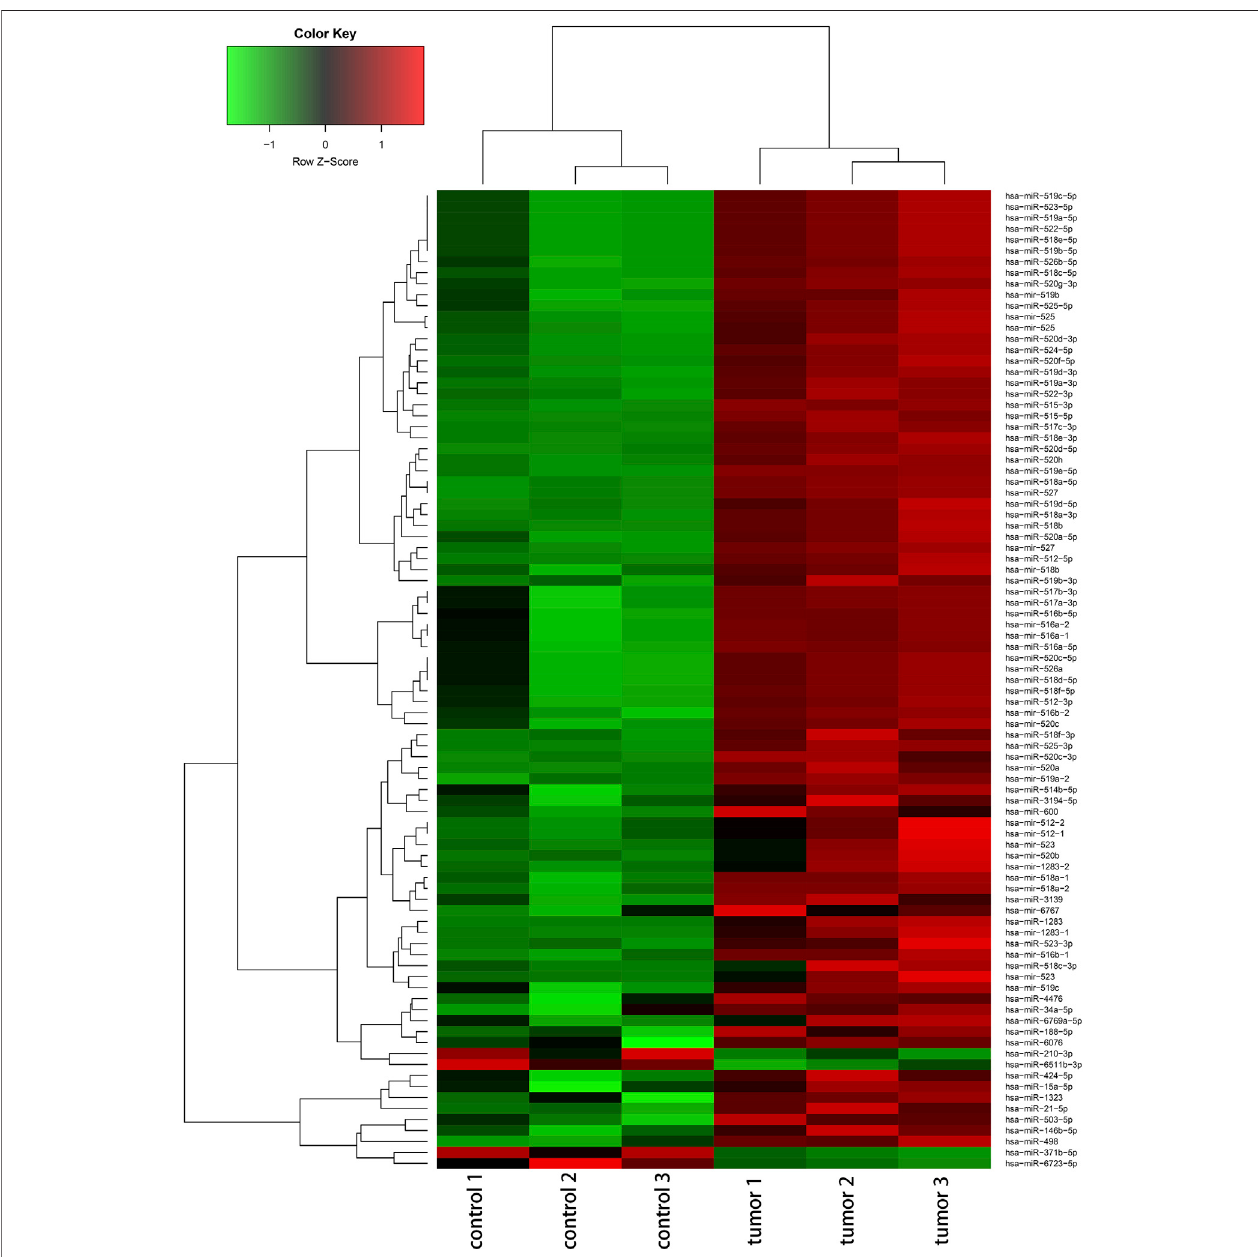
FIGURE 1 | Hierarchical cluster analysis of deregulated miRNAs (|fold change| ≥ 2 and FDR < 0.05) between IH and controls.